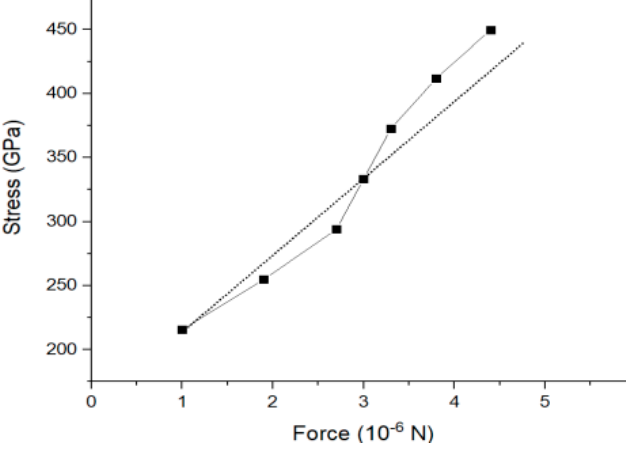
Figure 4. Graph of the relationship between stress and force.